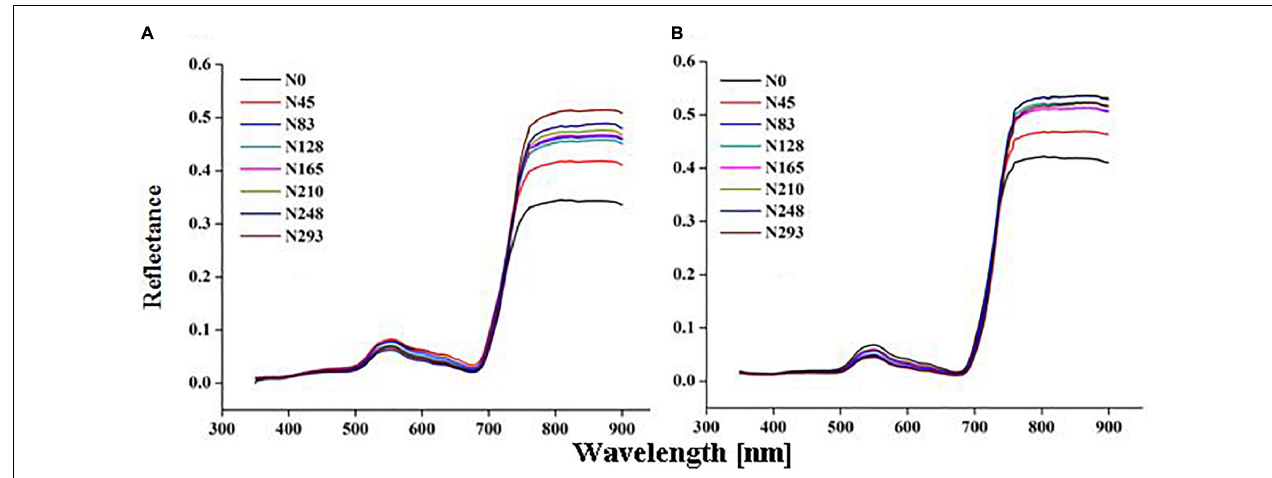
FIGURE 2 | Change in canopy reflectance spectra under different nitrogen (N) fertilization rates of rice in 2015 (A) 2016 (B) .